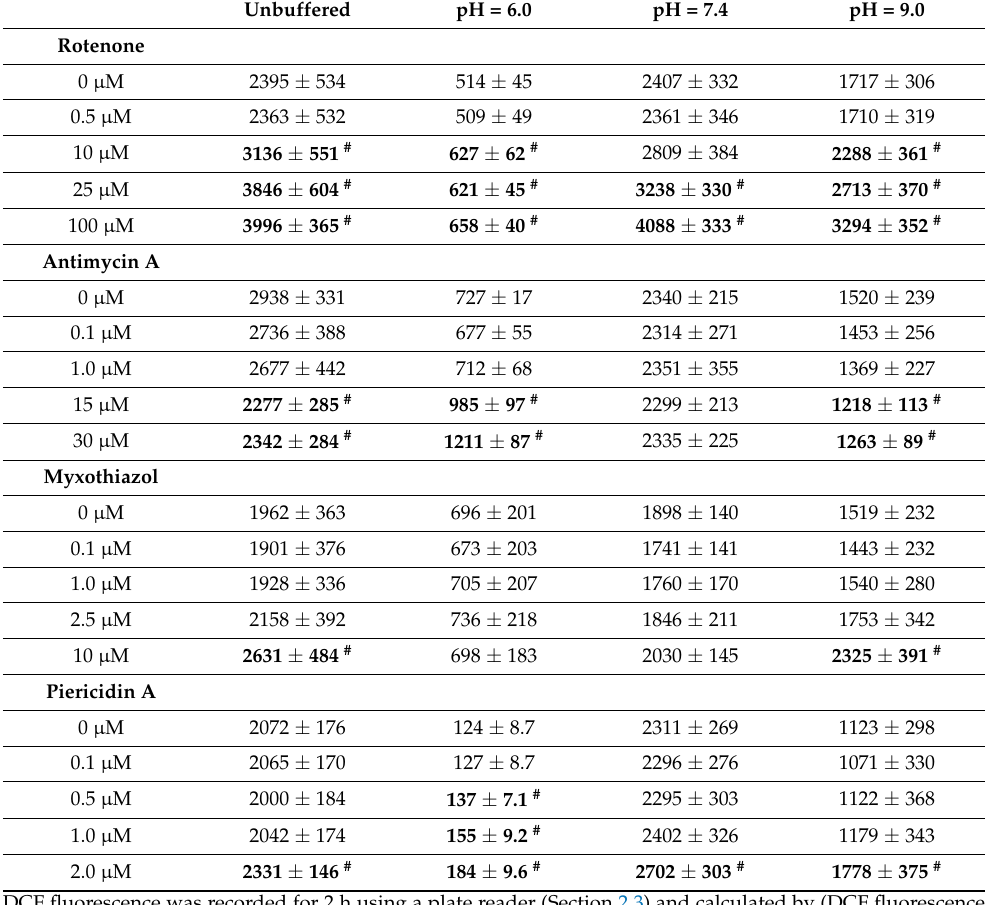
Table 1. Influence of ETC inhibitors on the formation of DCF from DCFH 2 -DA under cell-free conditions. The values represent the mean ± SD change in DCF fluorescence ( ∆ flu) in arbitrary units that were measured at the same spectrofluorometric settings (n = 8 per